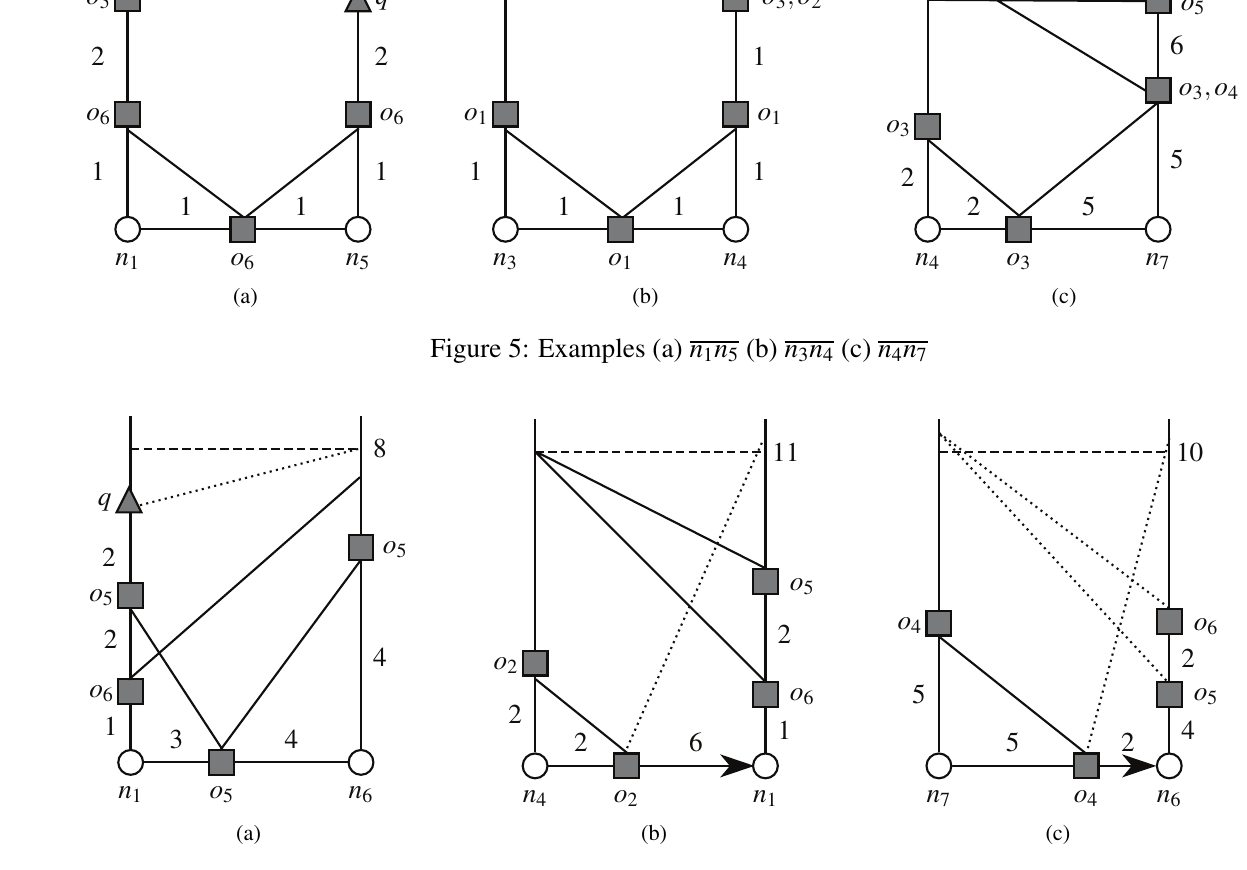
Figure 6: Examples (a) n 1 n 2 n 6 (b)